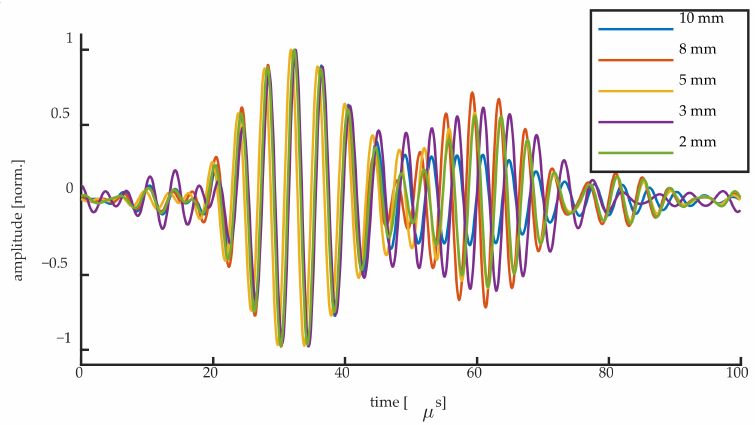
Figure 16. Normalized UGW signals obtained for all FBG lengths for the 250 kHz